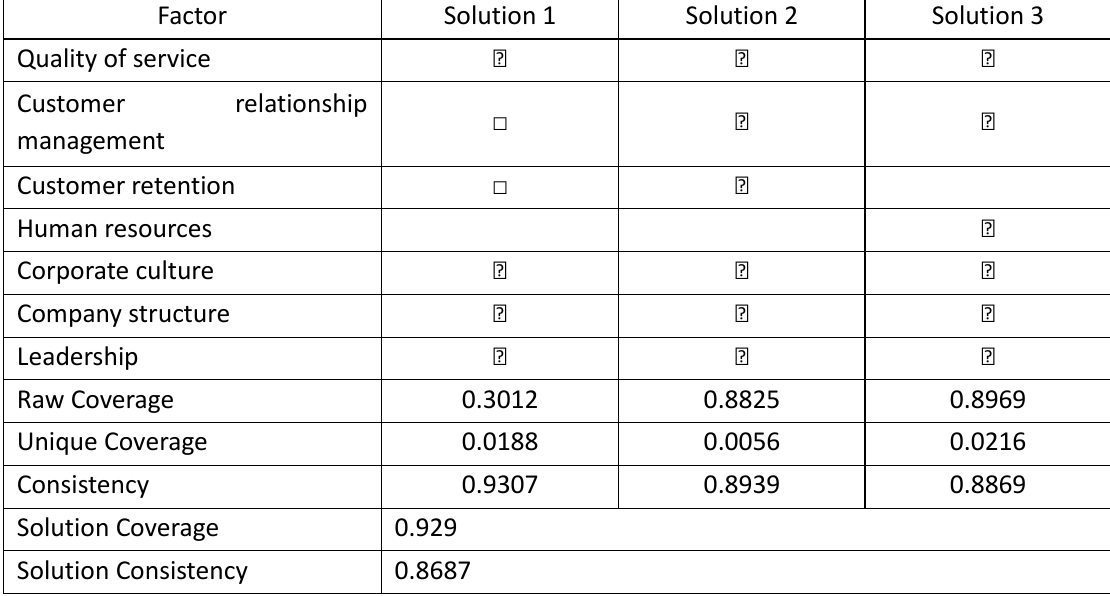
Table 2: Impact assessment of factors affecting the success of logistics enterprises (the other group)